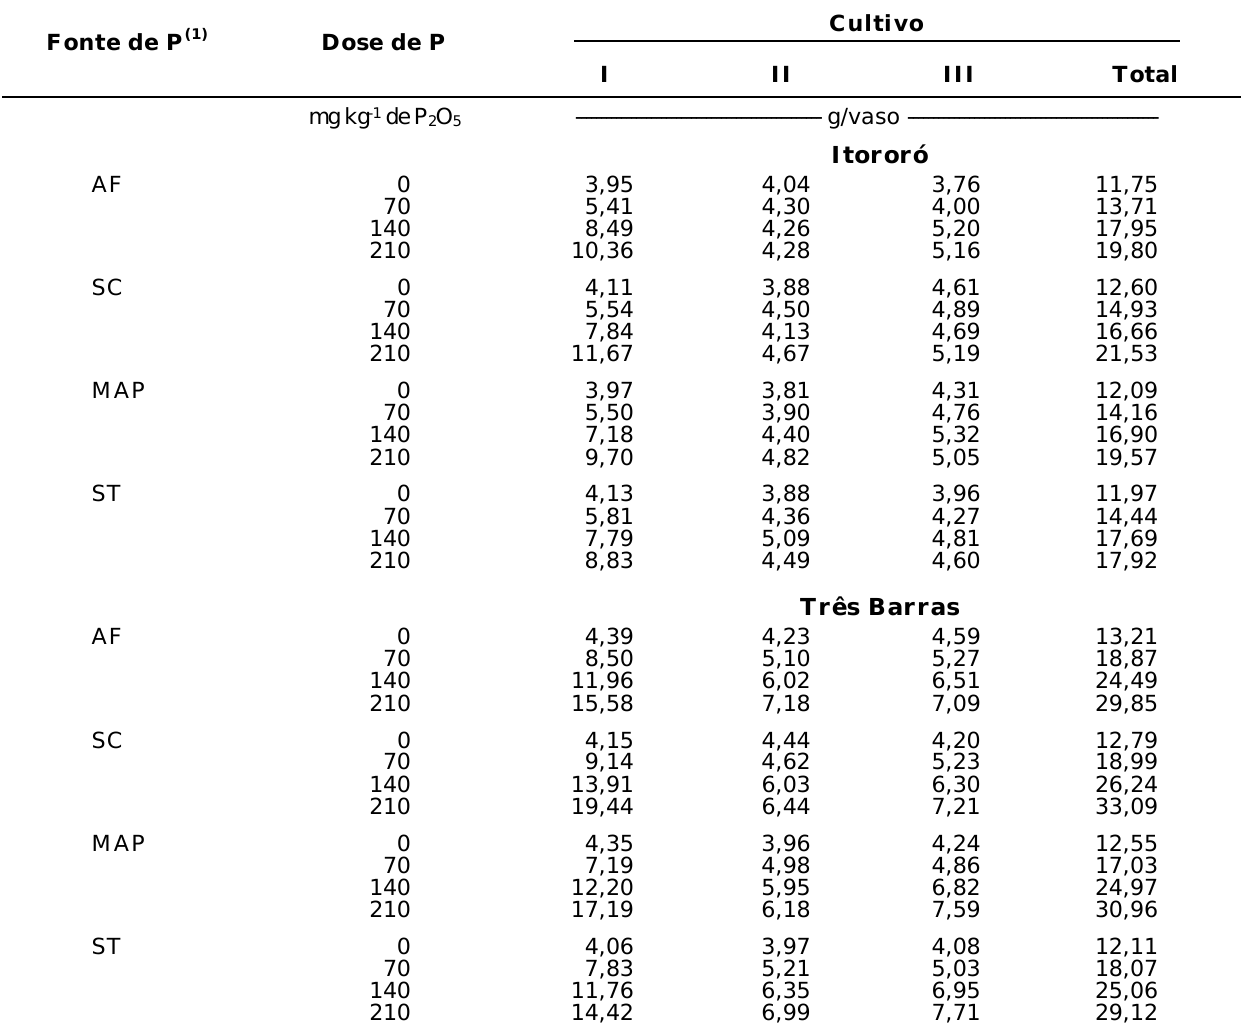
fontes e doses de fosfato, unidades Itororó e Três